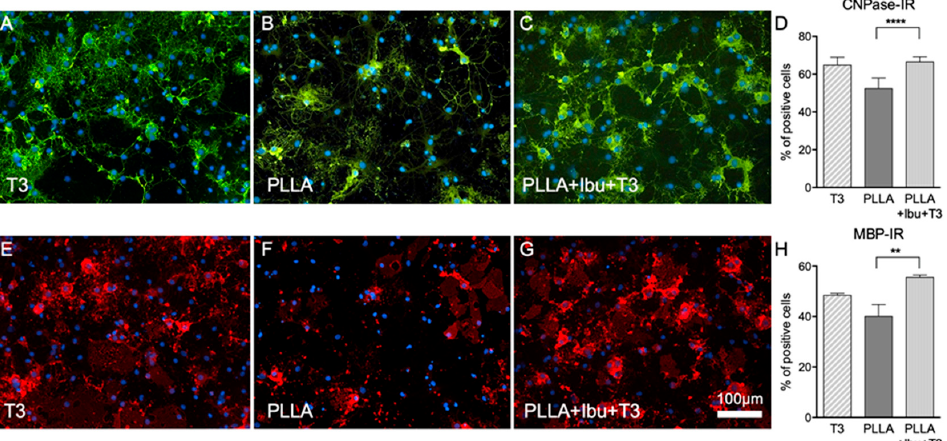
Figure 7. Effect of PLLA–Ibu–T3-conditioned medium on OPC maturation. Immunostaining of CNPase after exposure to soluble T3 ( A , 50 nM), PLLA alone ( B ), PLLA + IBU + T3 ( C ), and relative quantification ( D ). Immunostaining of MBP after exposure to soluble T3 ( E , 50 nM), PLLA alone ( F ), PLLA + IBU + T3 ( G ), and relative quantification ( H ). Statistical analysis: one-way ANOVA and post-hoc test, ** p < 0.01, **** p < 0.0001. Abbreviations: CNPase, 2 ′ ,3 ′ -cyclic-nucleotide 3 ′ - phosphodiesterase; DIV, days in culture; Ibu, ibuprofen; iNOS, inducible nitric oxide synthase; MBP, myelin basic protein; PLLA, poly( L -lactic acid); T3, triiodothyronine; TNF- α , tumor necrosis factor-alfa.